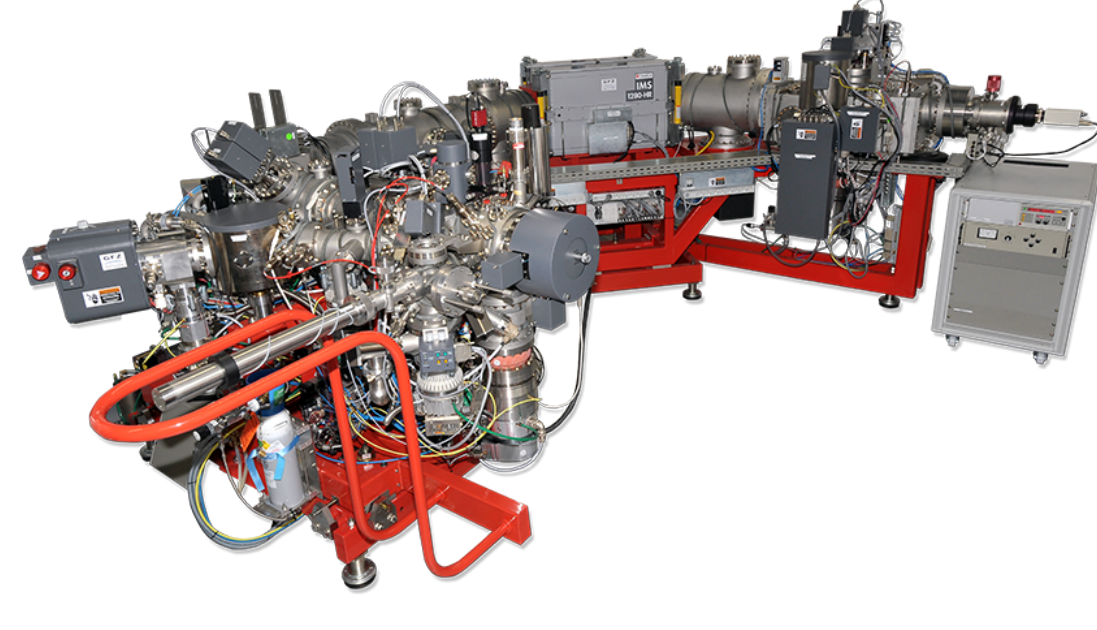
Figure 1: The Cameca 1280-HR instrument. The total length of the vacuum system is 8 meters. The vacuum pressure is between e-6 and e-7 Pa throughout most of the